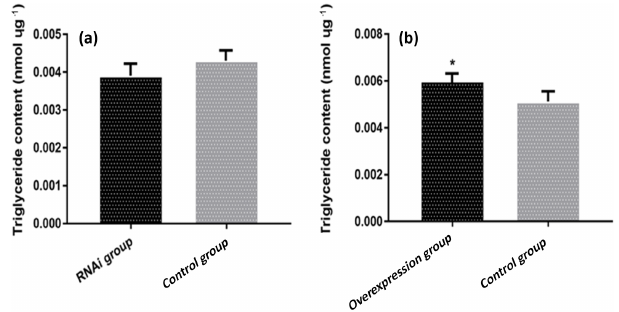
Figure 4. The content of triglyceride in preadipocytes of differ- ent transfection groups. (a) The triglyceride (TG) content of bovine preadipocytes transfected with the pBI-CMV3- ACSL5 and pBI- CMV3 vectors. (b) The TG content of bovine preadipocytes trans- fected with the shRNA- ACSL5 and pGPU6/GFP/Neo